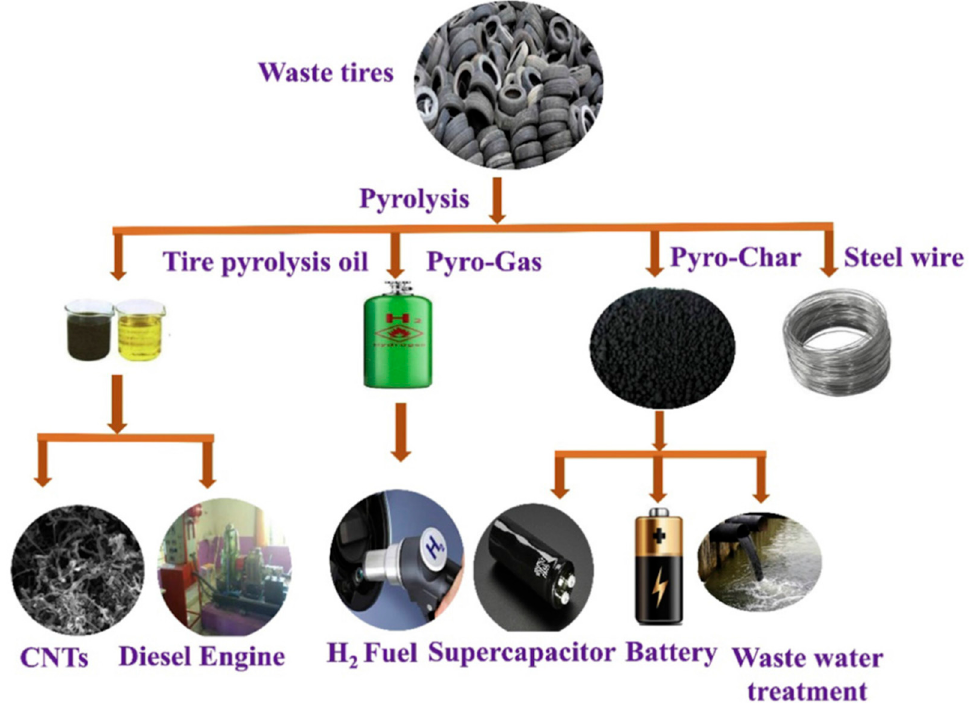
Figure 3. Waste tire pyrolysis products and their applications (reproduced with permission from [26]).